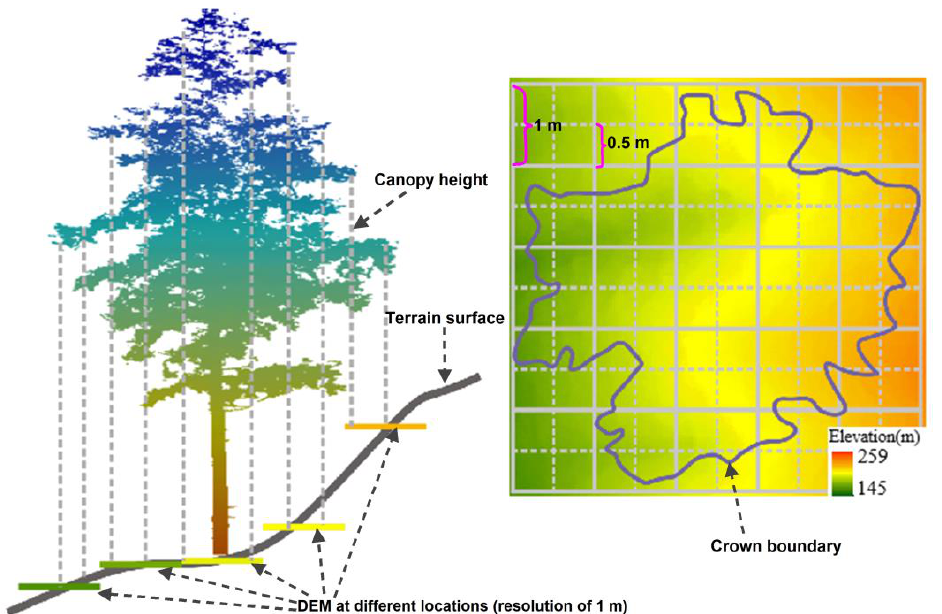
Figure 9. Schematic diagram of normalization of individual tree point cloud. (The short lines of different colors at the bottom of the left figure represent different DEM values, and the length is the pixel size of the corresponding DEM. The right figure is the top view of the left figure, each solid line grid is 1 m, and different colors represent different DEM